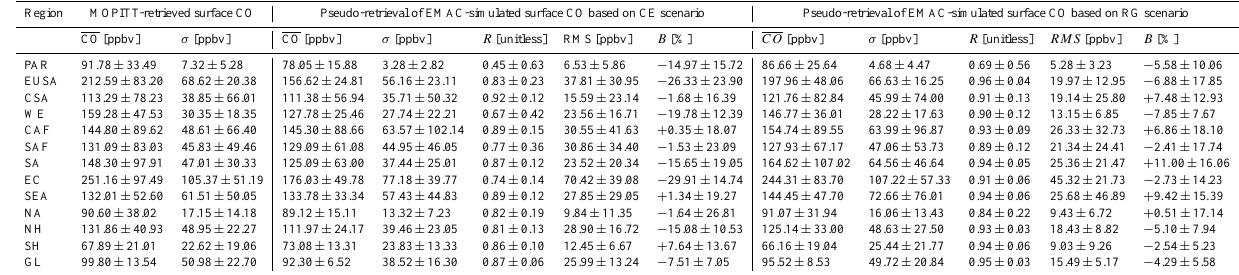
Table 3. Means (CO ) and corresponding statistic quantities* used in the comparison of spatial patterns (i.e., Taylor diagram in Fig. 4) in MOPITT-retrieved surface CO and pseudo-retrievals of EMAC-simulated surface CO. Region MOPITT-retrievedsurfaceCO Pseudo-retrievalofEMAC-simulatedsurfaceCObasedonCEscenario Pseudo-retrievalofEMAC-simulatedsurfaceCObasedonRGscenario